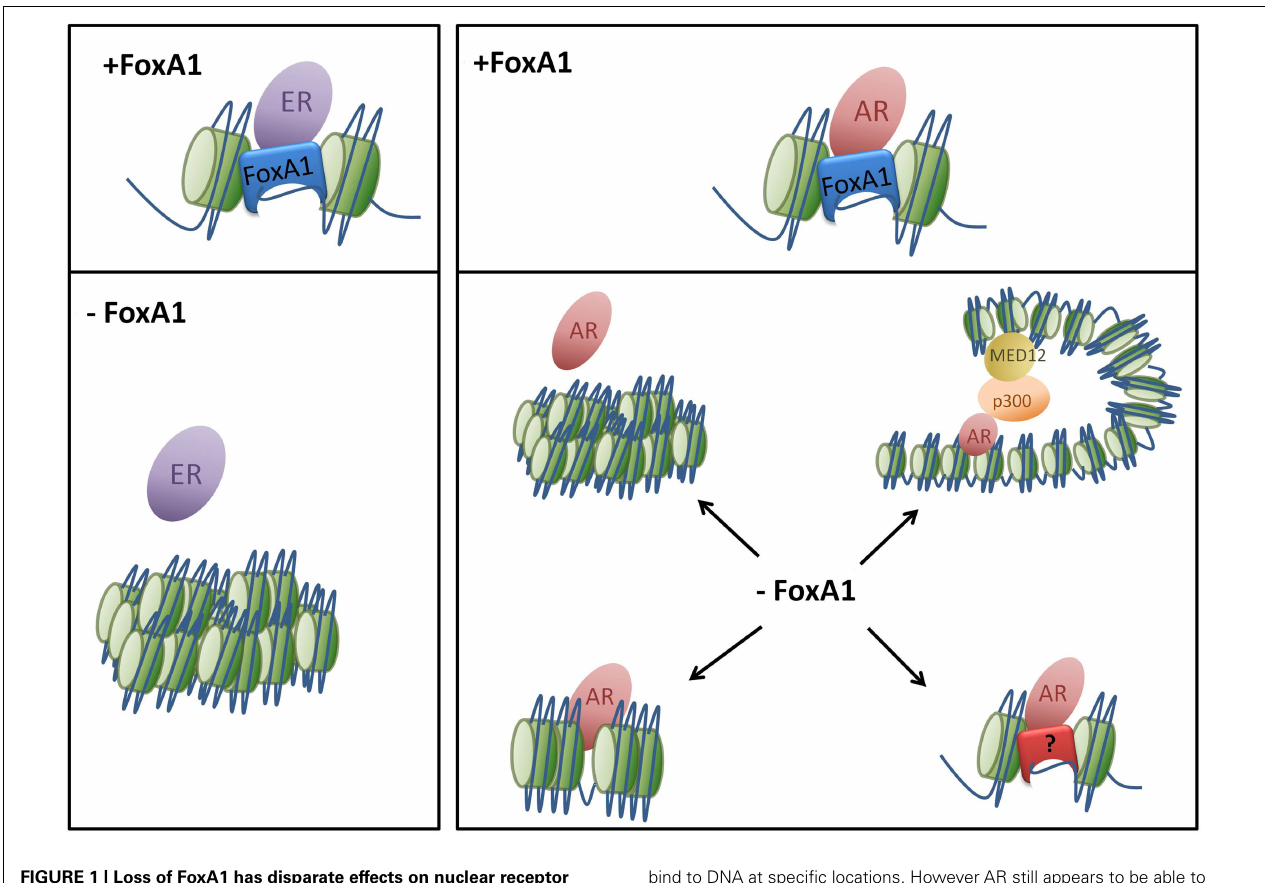
FIGURE 1 | Loss of FoxA1 has disparate effects on nuclear receptor binding. FoxA1 acts as a pioneer factor for ER and AR allowing the nuclear receptors to make targeted contacts with specific genomic regions which induce a transcriptional response.The loss of FoxA1 results in condensation of the chromatin so ER and AR can no longer